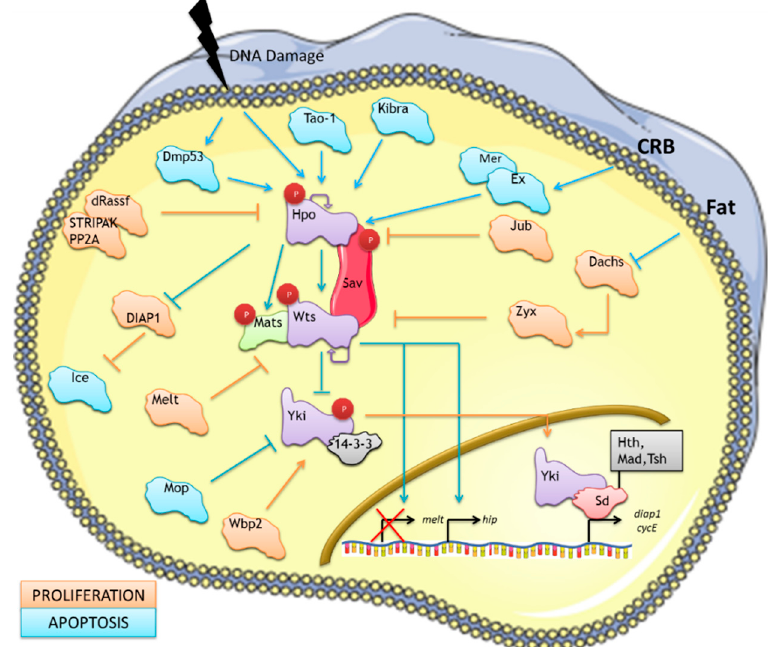
Figure 1. The regulation of Hippo signalling in Drosophila melanogaster. The scheme summarises the canonical Hippo pathway and some of the non-canonical functions described to date. The proliferative signals are represented in orange and the pro-apoptotic signals are represented in blue. The black box illustrates the newly described transcription factors binding to